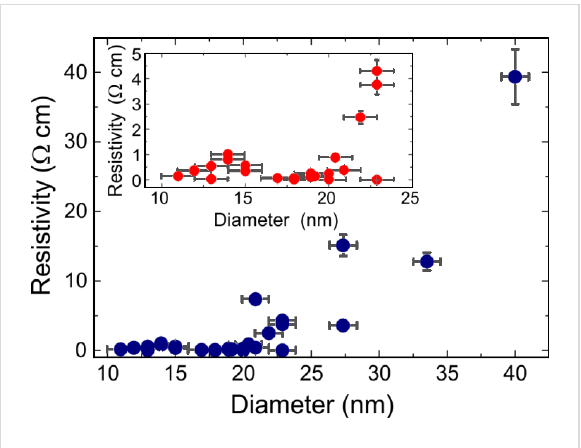
Figure 1: Resistivity of nanowires with 40 to 11 nm diameter. The resistivity decreases by two orders of magnitude with reducing diame- ter. In the range of 27 to 20 nm an increased scattering of the resis- tivity values is observed. Below 20 nm the resistivity variation is signifi- cantly smaller. Inset: Data for NWs with diameter below 25 nm. At around 14 nm a peak-like feature is found.